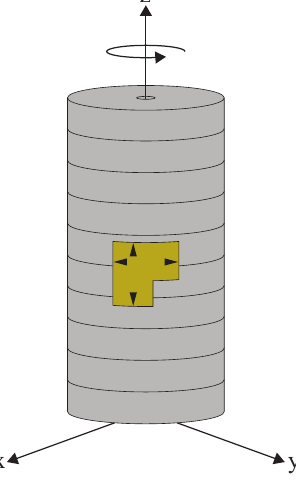
Figure 3. Geometry of a 0 ◦ specimen assuming TI symmetry featuring a biaxial strain gauge with triangles indicating measurement